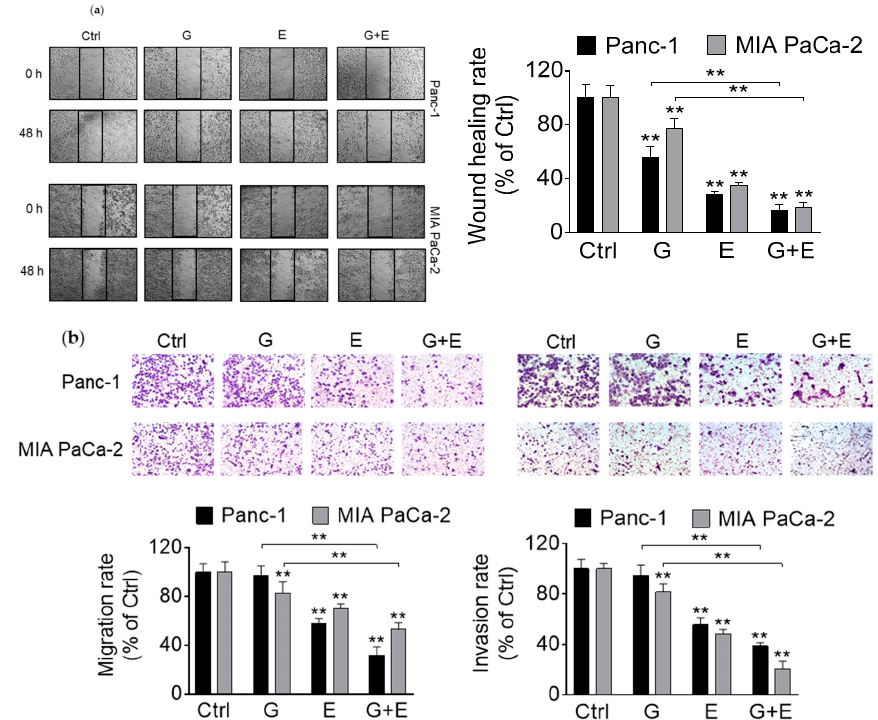
ff ect of gemcitabine on cell migration and invasion. ( a ) Panc-1 Figure 6. EGCG enhances the inhibitory effect of gemcitabine on cell migration and invasion. ( a ) Panc- Figure 6. EGCG enhances the inhibitory e and MIA PaCa-2 cells were treated with EGCG (E), gemcitabine (G), or both (G + E) for 48 h, and the wound healing rate was determined. Results are expressed as a percentage of control. ** p < 0.01 vs. control. ( b ) Migration (left) and invasion (right) rate were further decreased by the combo in Panc-1 and MIA PaCa-2 cells. Representative images are shown ( × 200). Results are expressed as a percentage of control. ** p < 0.01 vs.